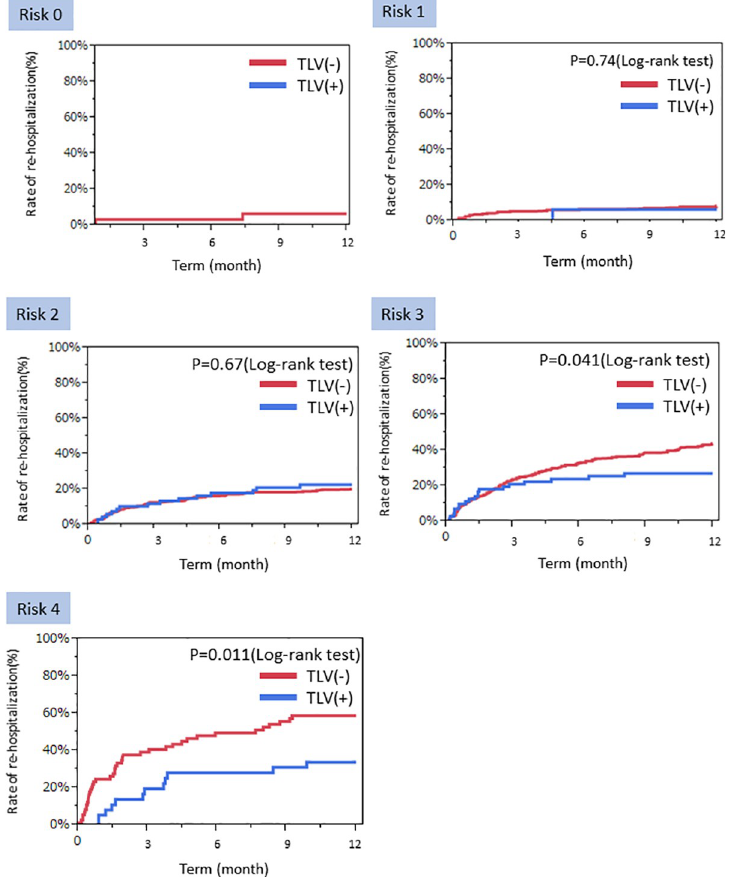
Fig 4. Cumulative incidence curves of re-hospitalizations risk. Cumulative incidence curves of re-hospitalizations risk for worsening of heart failure after 1-year follow-up in the validation subset based on their risk score. Comparison of TLV versus no